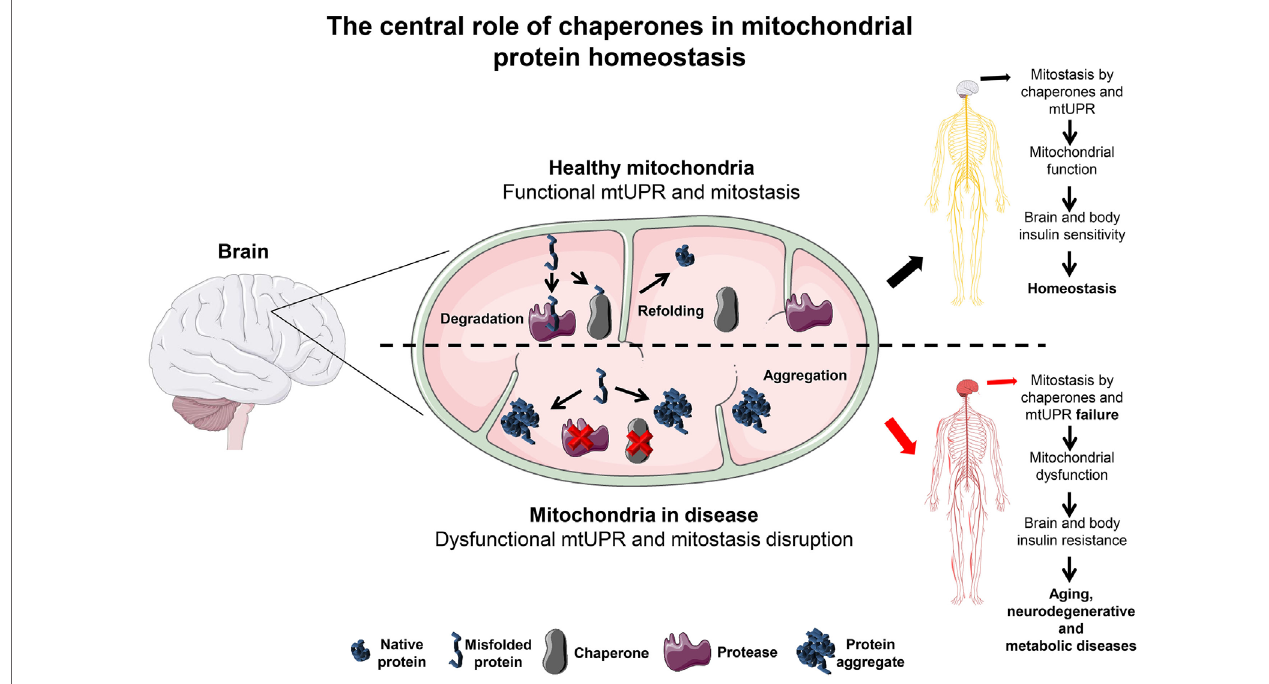
FiGUre 1 | The central role of chaperones in mitochondrial protein homeostasis. In the brain, mitochondria are kept under optimal functional conditions by employing two major mitochondria homeostasis (mitostasis) processes, (re)folding and degradation. Under tight regulation and concerted action these processes avoid the accumulation of different types of damage such as ROS, mitochondrial DNA mutations or misfolded/aggregated proteins known to promote mitochondrial dysfunction. Moreover, a mild increase in the level of misfolded proteins triggers the UPRmt response that quickly helps to establish mitostasis. In the brain, under these conditions, chaperones promote mitochondrial function keeping the brain and whole body in an insulin sensitive state. In contrast, if refolding or degradation processes become impaired due to the loss of mitochondrial chaperones expression or activity this results in misfolded and aggregated protein accumulation. This detrimental state leads to oxidative stress that can affect mitochondrial function and thus brain metabolism. A likely consequence is the resistance to insulin not only initially in the brain but also to peripheral tissues later on, abrogating whole body metabolic homeostasis. This metabolic shift is a likely percursor for aging, neurodegenerative and metabolic diseases progression, and establishment. Servier Medical Art by Servier is licensed under a Creative Commons Attribution 3.0 Unported License.